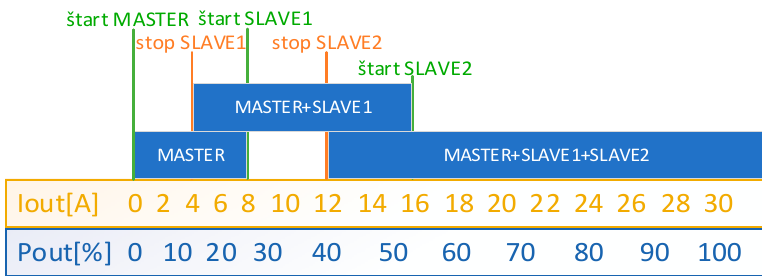
Figure 13. Technique of the sequential switching of MAPS within MASTER-voltage, SLAVE-current control strategy .